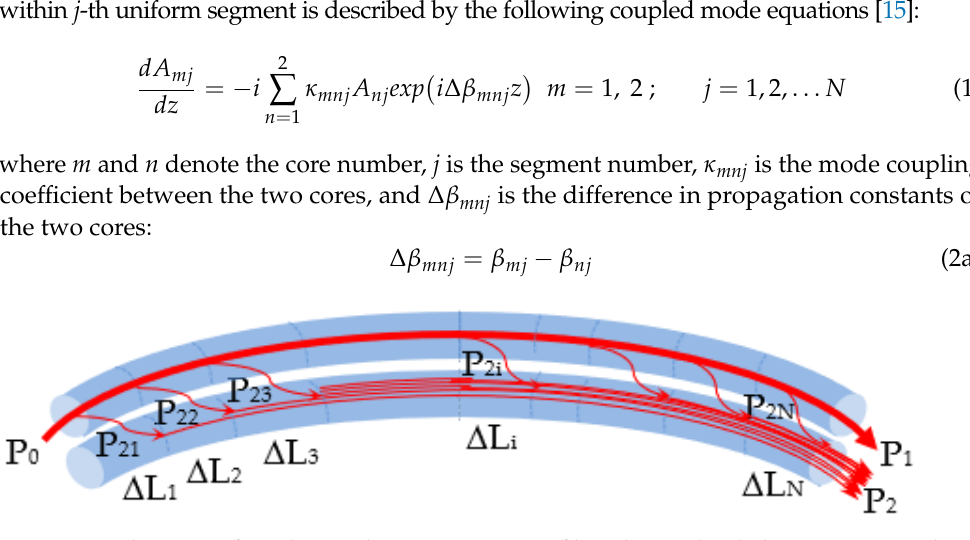
Figure 1. Schematic of mode coupling in a two-core fiber that is divided into N uncorrelated uniform segments.